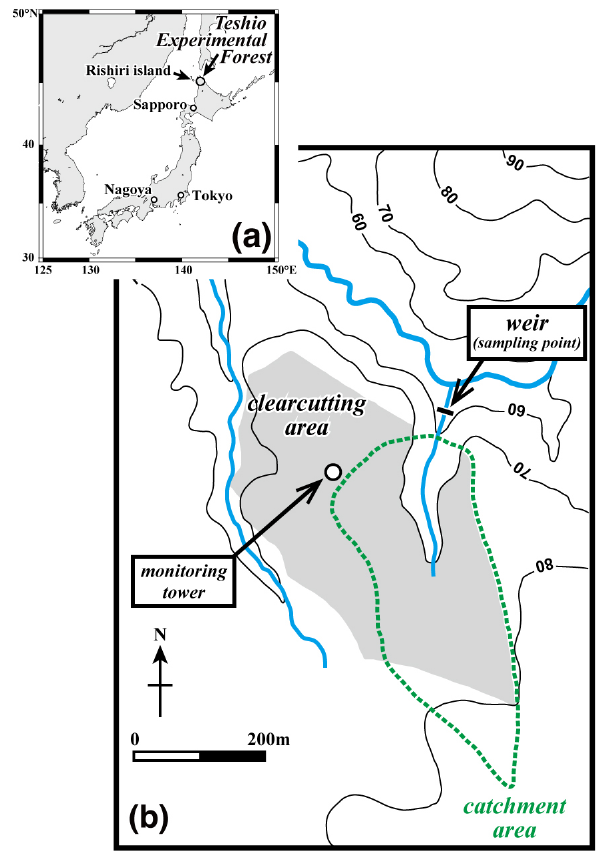
Figure 1. Map showing the location of Teshio Experimental Forest in northern Japan (a) , and a contour map showing the water sam- pling point (weir) in the forest (b) , together with both the catchment area shown by a dotted line and the clear-cutting area of the CC-LaG project shown by the hatched region. The white circle denotes the location of the monitoring